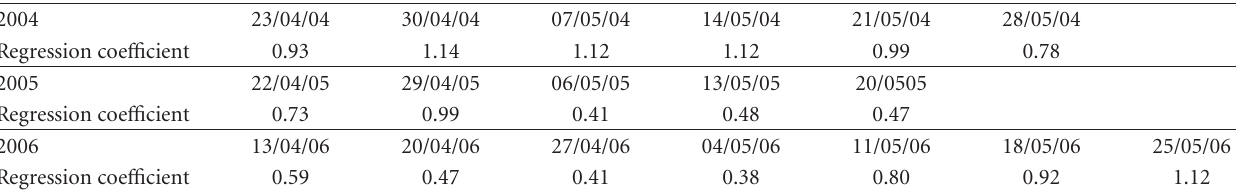
Table 5: Cross-validation summary